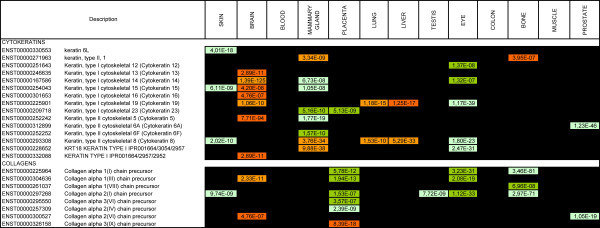
Patterns of differential expression for collagen and cytokeratin genes in multiple normal and tumor tissues. The data are shown in a table format, in which rows represent individual genes and columns represent individual normal tissue. The color in each cell reflects the differential expression level of the corresponding gene in a particular tissue. A four color code was used to represent gene induction and repression in cancer libraries (dark green: 'normal-specific', i.e. not expressed in tumor libraries; light green: downregulated in tumor libraries; orange: upregulated in tumor libraries; red: 'tumor-specific'). If there was no significant change in gene expression between normal and tumor libraries or in case of missing/excluded data, the gene was given in a black color. The number inside the colored cells indicates the statistical significance (p-value < 0.01 after Bonferroni correction). See additional information for the full data.